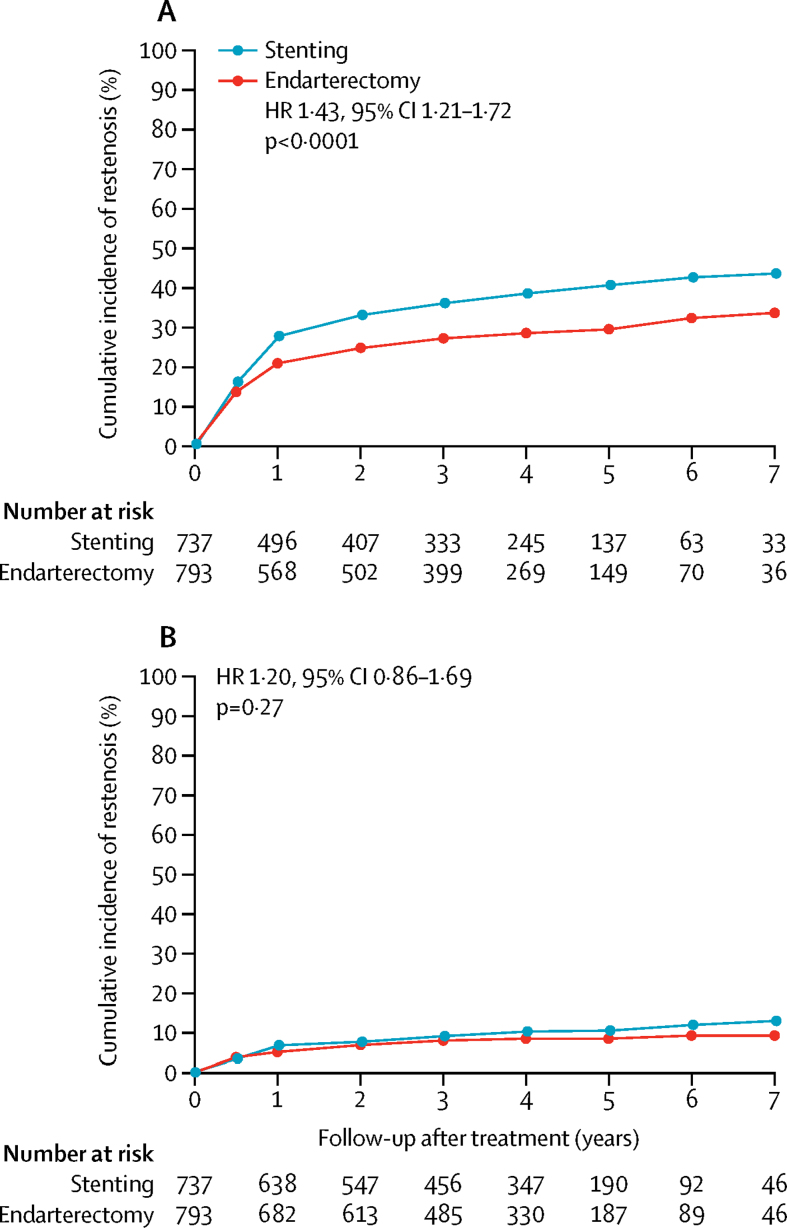
Cumulative incidence of (A) at least moderate (≥50%) carotid artery restenosis or occlusion and (B) severe (≥70%) carotid artery restenosis or occlusion after completed treatmentCumulative incidence was estimated by life-table analysis. Plots stop at 7 years' follow-up because the number of patients at risk beyond that time was fewer than 100, but analyses were based on all follow-up data (maximum 10 years). HR=unadjusted hazard ratio.